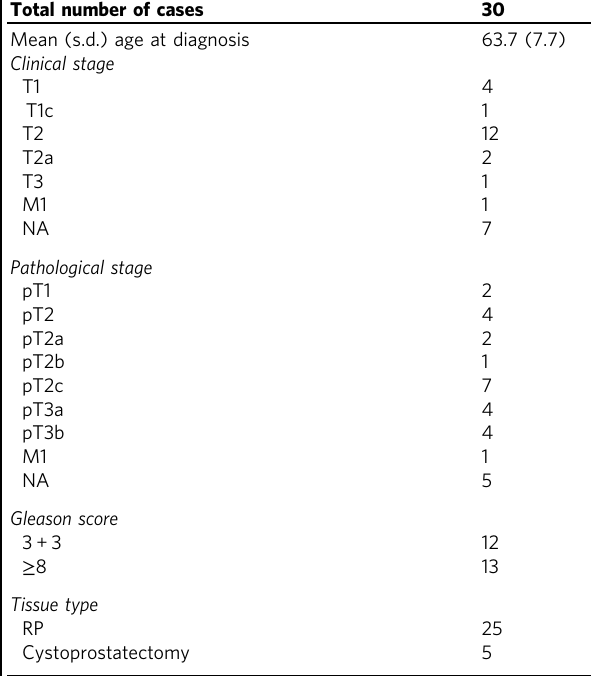
Table 1 Clinical characteristics of the LCM